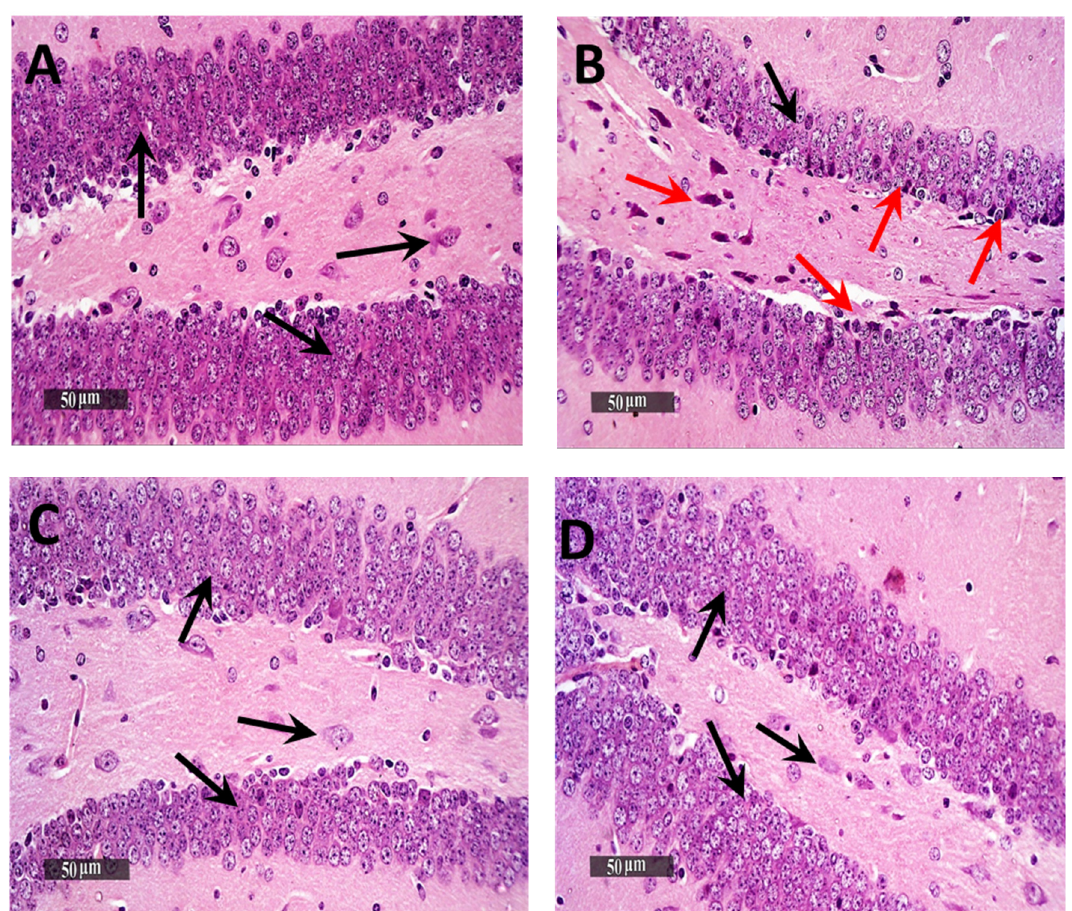
Figure 6. Light-microscopic examination of toluidine blue-stained pyramidal neurons in CA3/hippocampal sub-regions in different groups. ( A ) normal group, ( B ) negative control group (received 0.9% saline), ( C ) positive control group (received resveratrol suspension) and ( D ) test group (received resveratrol bilosomes). 400X. Black arrows = intact neurons, Red arrows = damaged neurons. The bar chart ( E ) shows the mean ± SD of the intact neuron count of CA3 in different groups where Gp 1 represents the normal group, Gp 2, Gp 3 and Gp 4 represent the negative control group (received 0.9% saline), positive control group (received resveratrol suspension) and test group (received resveratrol bilosomes), respectively, where (*) and (**) indicate statistically significantly different values from the control group at ( p < 0.05 and p < 0.01), respectively.